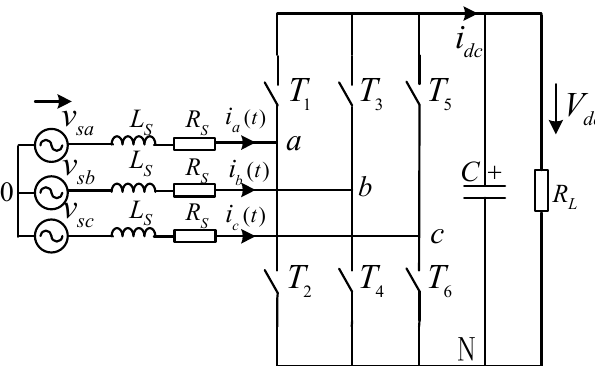
Figure 1. The topology of three ‐ phase pulse width modulation (PWM) rectifier.